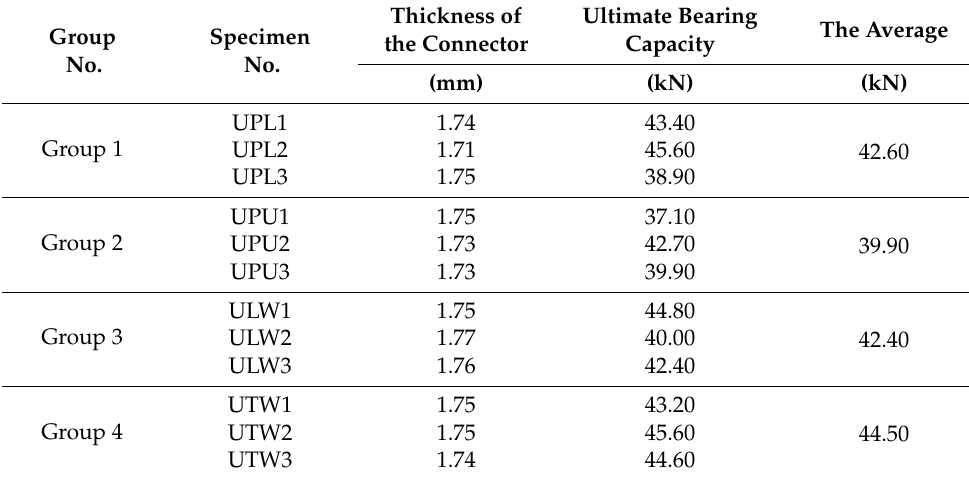
Table 3. Ultimate bearing capacity of each